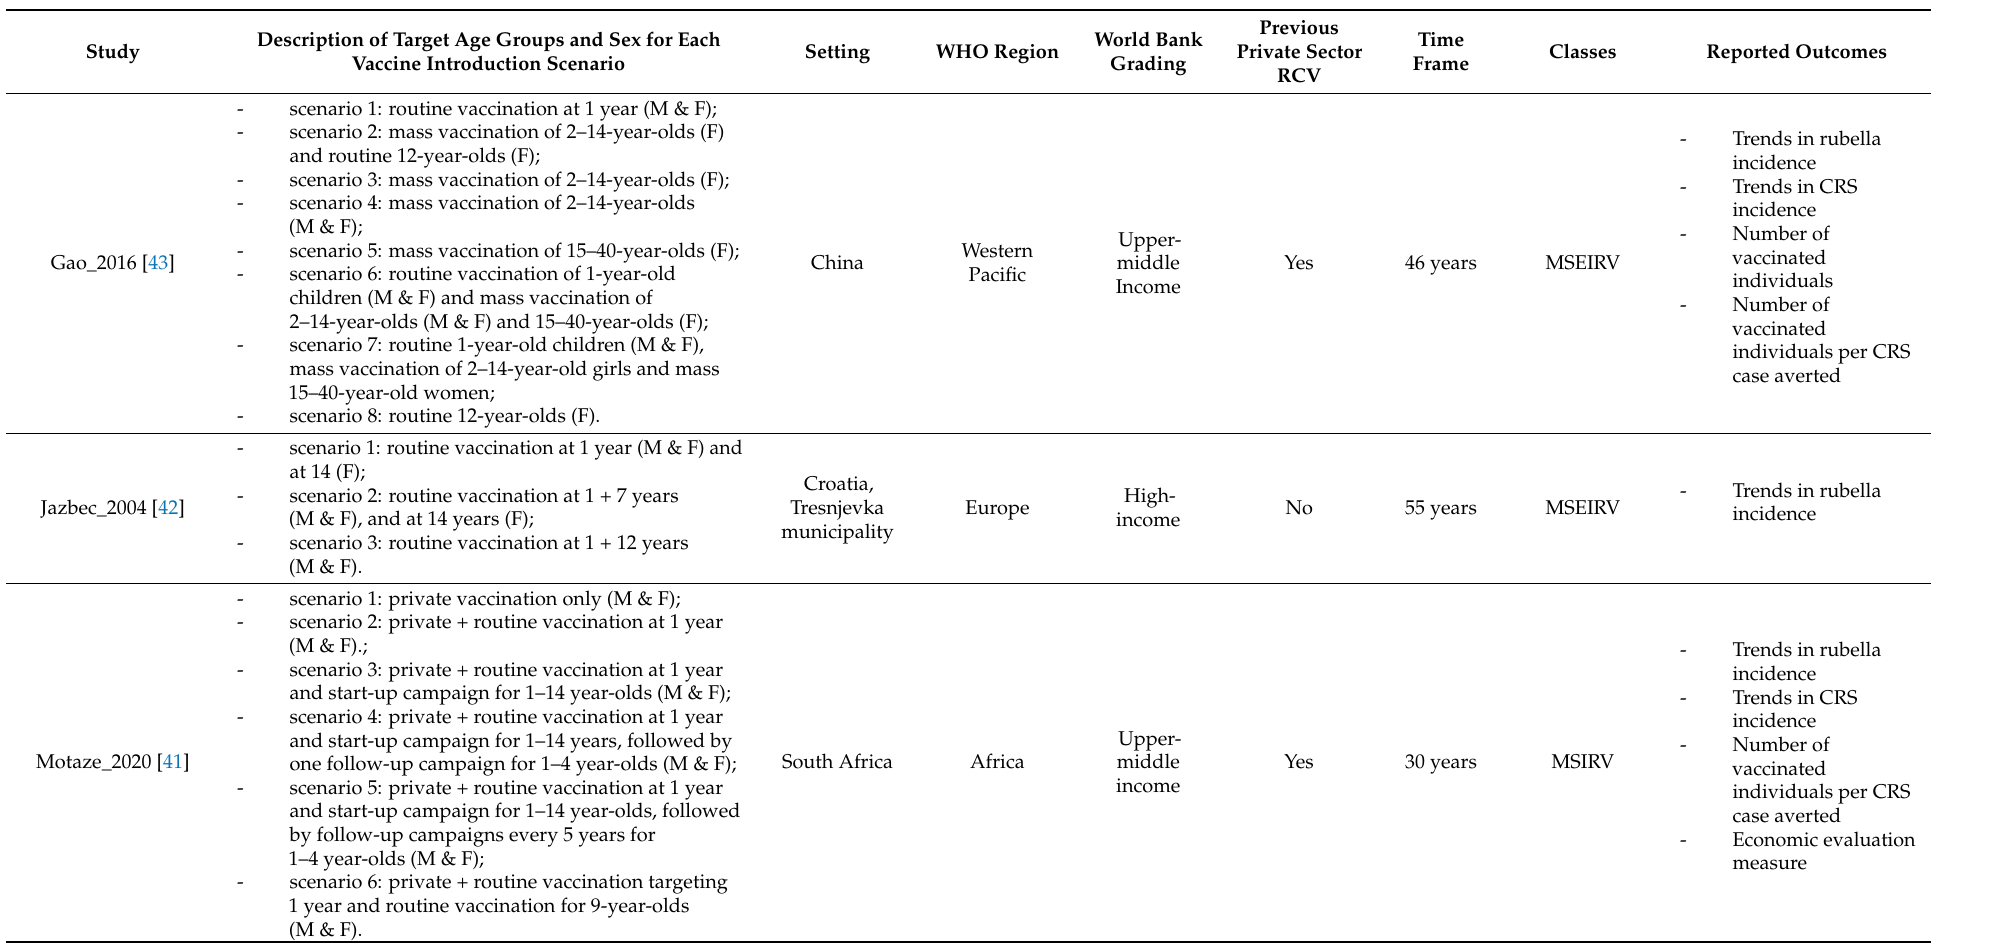
Table 1. Characteristics of included